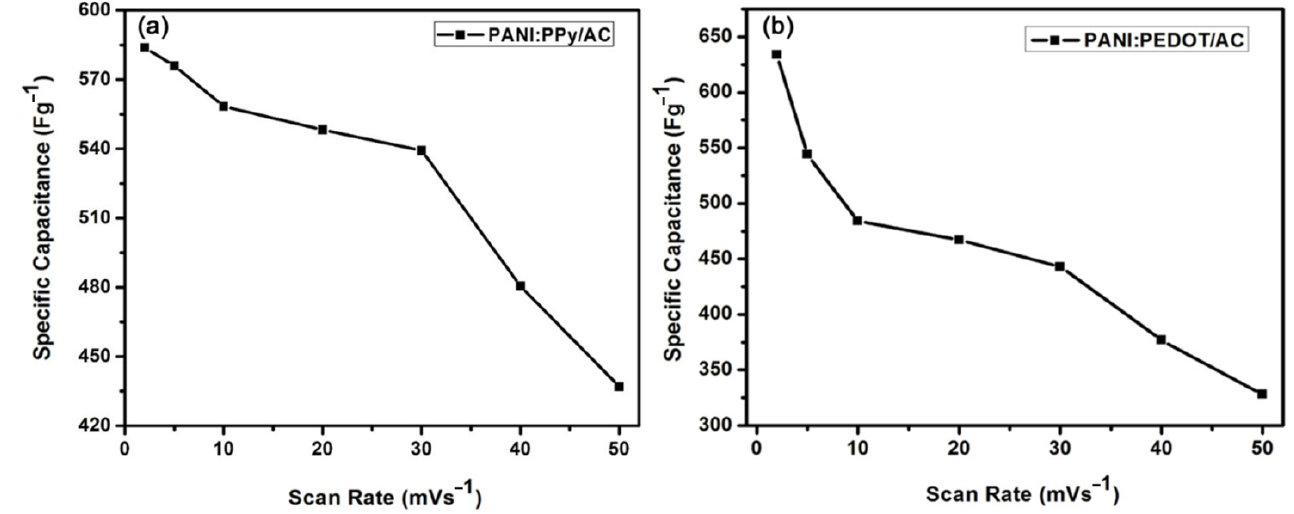
Figure 6. Specific capacitance versus scan rate recorded for ( a ) PANI:PPy/AC and ( b ) PANI:PE- DOT/AC.